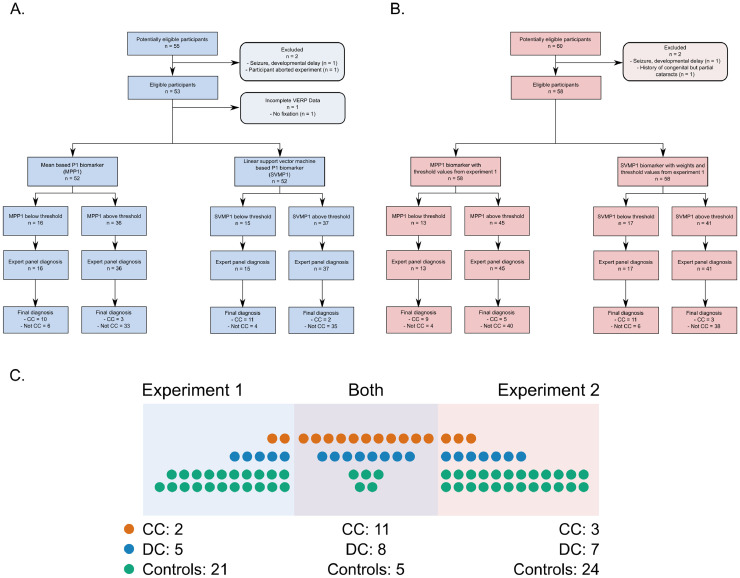
A. Standards for Reporting of Diagnostic Accuracy (STARD) flow diagram for P1 amplitude based diagnostic biomarker development (experiment 1), and B. Validation in experiment 2 with classification thresholds developed from experiment 1. C. Venn diagram showing participant overlap in the two experiments (CC: Participants with a history of congenital dense bilateral cataracts and subsequent vision restoration, DC: Participants with a history of bilateral developmental cataracts and subsequent vision restoration).